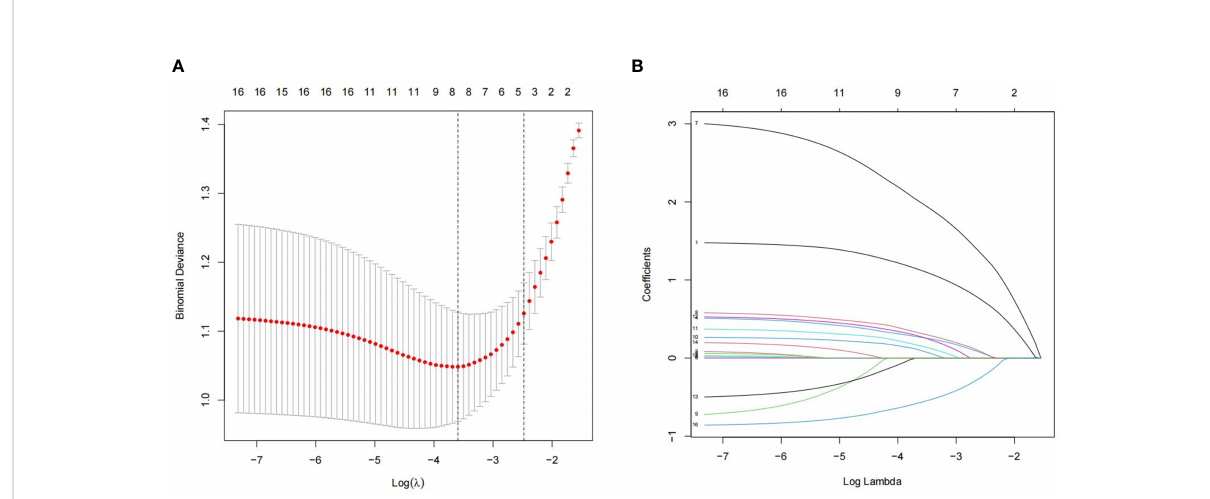
FIGURE 1 Least absolute shrinkage and selection operator (LASSO) logistic regression for assessing the relationship between populations and clinical features. (A) The optimum parameter in the LASSO regression model was chosen using a threshold of 16 cross-validations. The partial probability variance curves and the logarithm turn are shown. To get the best estimate, we used the 1-SE technique with minimum standards. (B) For each of the 16 characteristics, the LASSO logistic regression coef fi cients were calculated. The logarithmic lambda was used to determine the pro fi le. The ideal lambda was tested using a cross-validation technique, with the optimal lambda producing eight coef fi